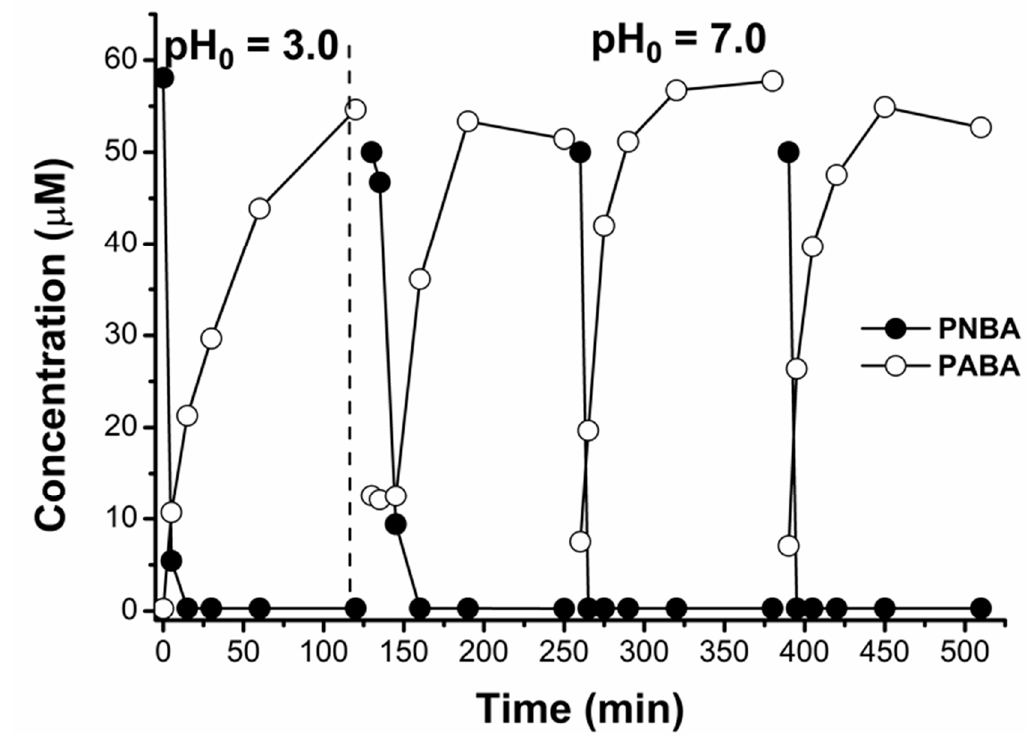
Figure 7. First PNBA 60 µM reduction at pH 3.0 with 1.4 g/L of mZVI in NW, and its subsequent reuses at pH 7.0. 10 min between each cycle was required for mZVI decantation and supernatant separation.